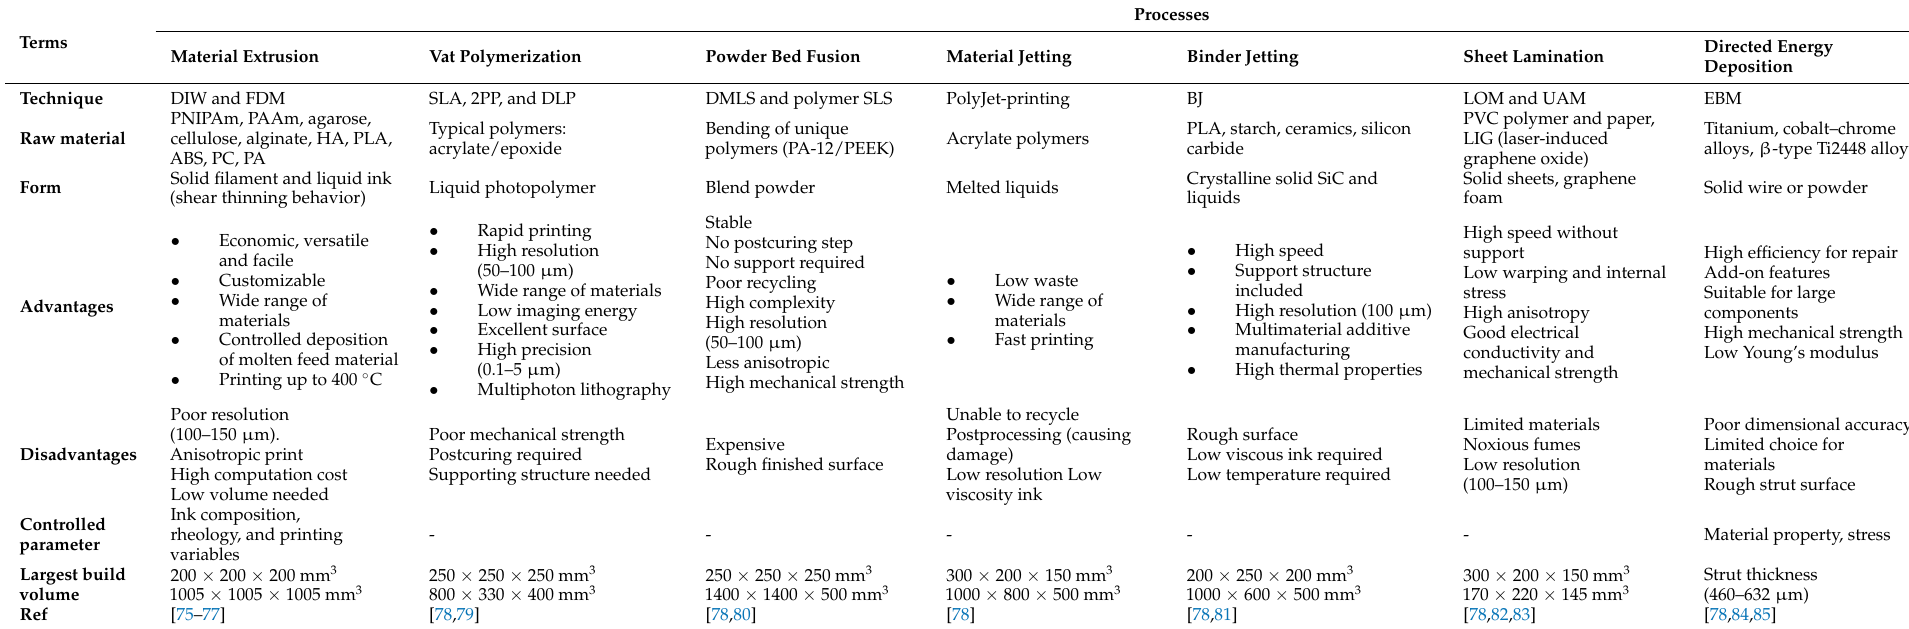
Table 3. Various techniques/processes, pros and cons, and materials used to fabricate 4D